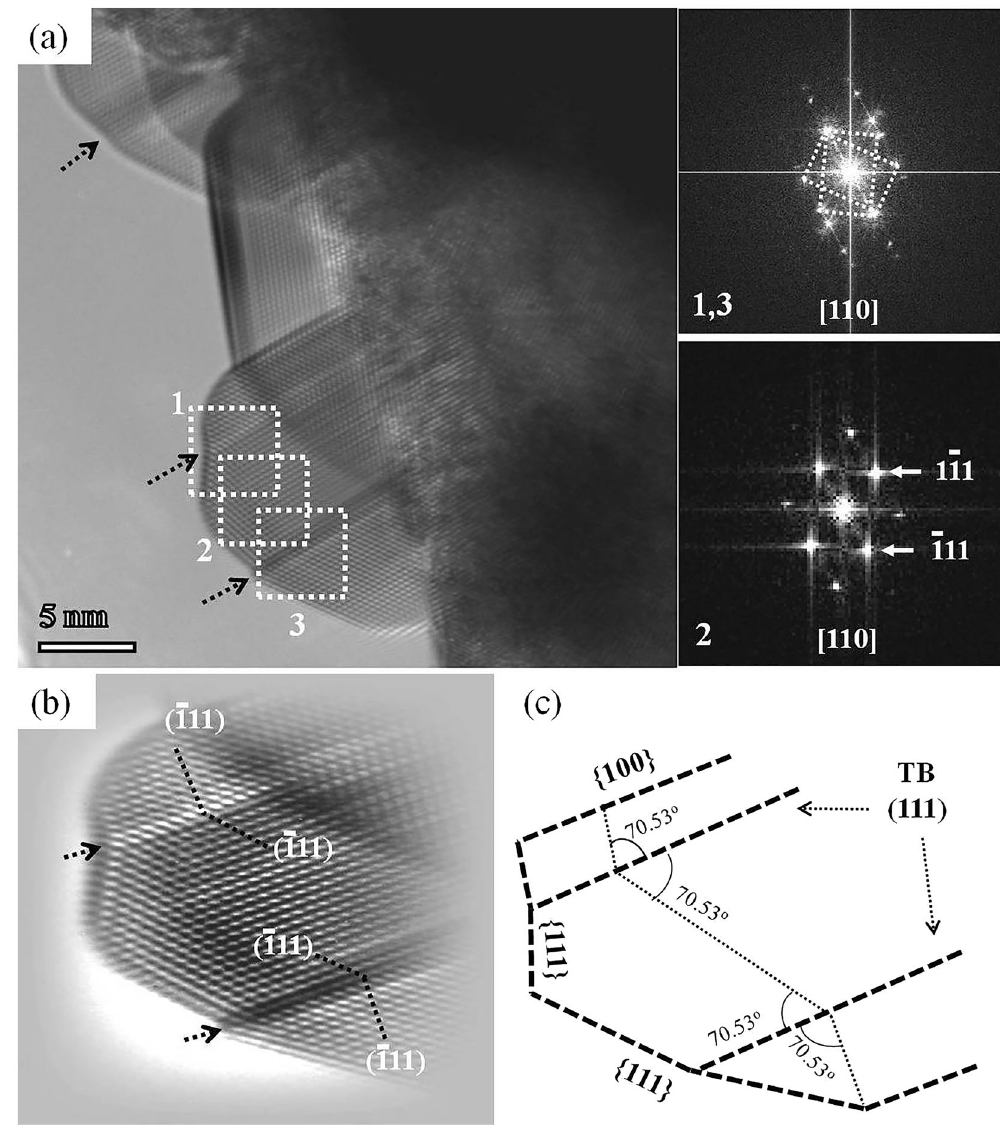
Figure 4. ( a ) HRTEM image of twinned Pb-PTO nanomaterial in [110] zone axis. The right side images 1, 3 and 2 are corresponding FFT pattern of twinned Pb, the selected area shown in Fig. 4 (a) by dotted rectangles. ( b ) FFT image of the twinned Pb nanocrystal in Fig ( a ). ( c ) Schematic diagram of the twinned Pb